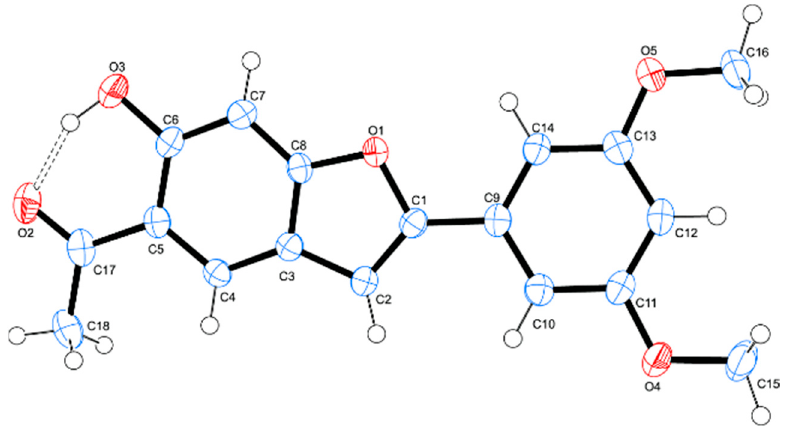
Figure 1. Oak Ridge Thermal Ellipsoid Plot (ORTEP) diagram (50% probability level) of 2h showing atom numbering scheme.